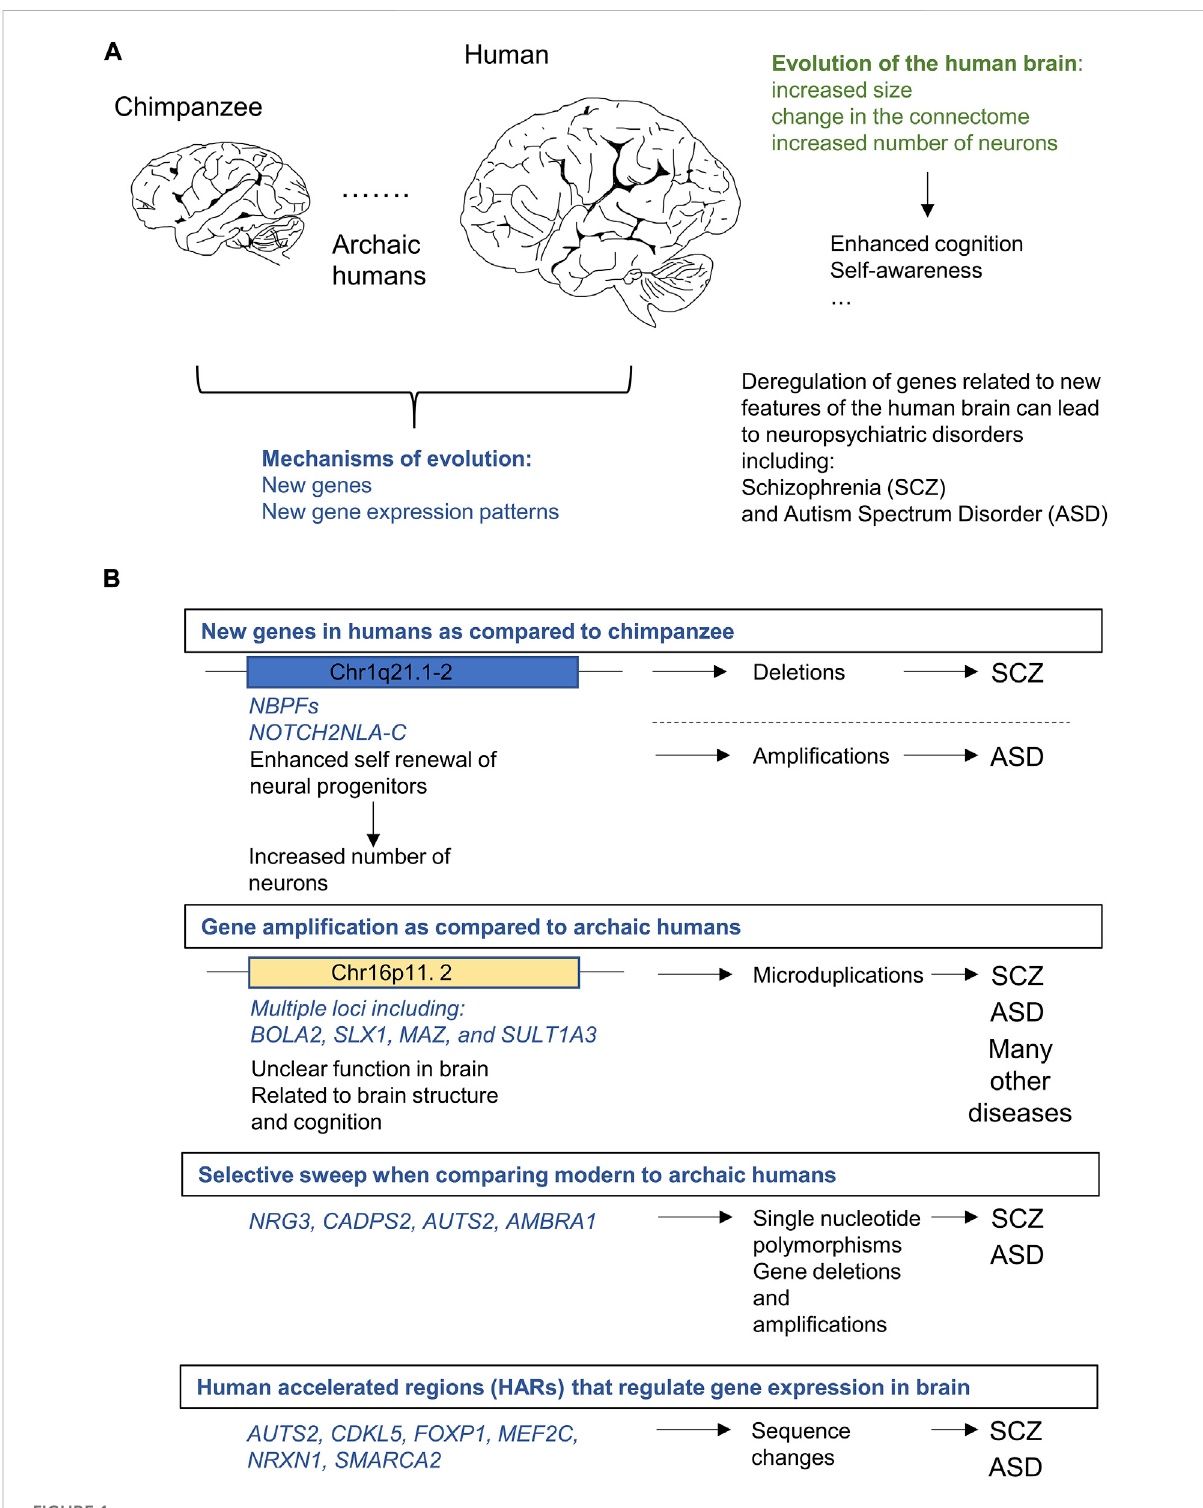
FIGURE 1 Genetic alterations in loci related to human brain evolution can lead to neuropsychiatric disorders speci fi cally affecting self-awareness and cognition includingschizophrenia (SCZ)and autismspectrum disorder (ASD). (A) . Humanbrain islarger andcontainsmore neuronsthan thebrainof ourclosestlivingrelativethechimpanzee( Pantroglodytes ).Evolutionledtotheenhancementofseveralfeaturesofhumanbrainincludingcognition andself-awareness.Thereisalsoaconsiderabledegreeofconvergencebetweengeneticchangesthatunderliebrainevolutionandlocirelated to neuropsychiatric disorders. (B) . Examples of genetic alterations in the human lineage related at the same time to evolution of SCZ or